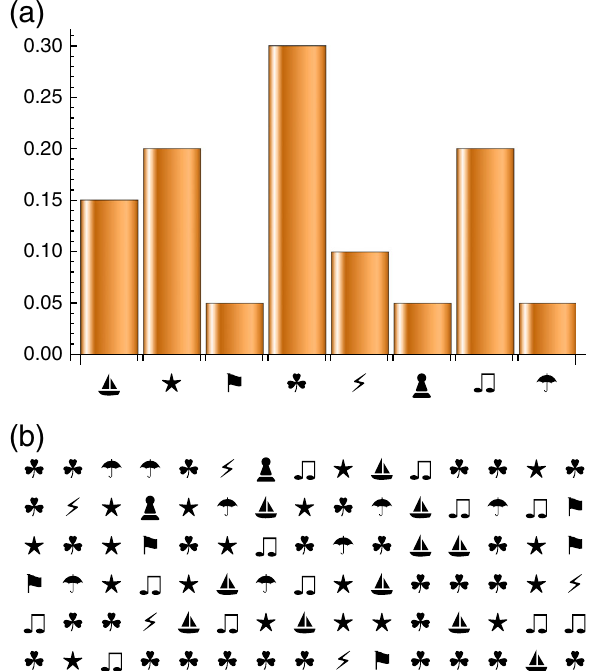
Fig. 1 a An example probability distribution over 8 symbols. b 100 random samples from this probability distribution. The objective of a sampling problem is to compute samples like the sequences shown in b whose complexity may be different to the complexity of computing the underlying probability distribution ( a